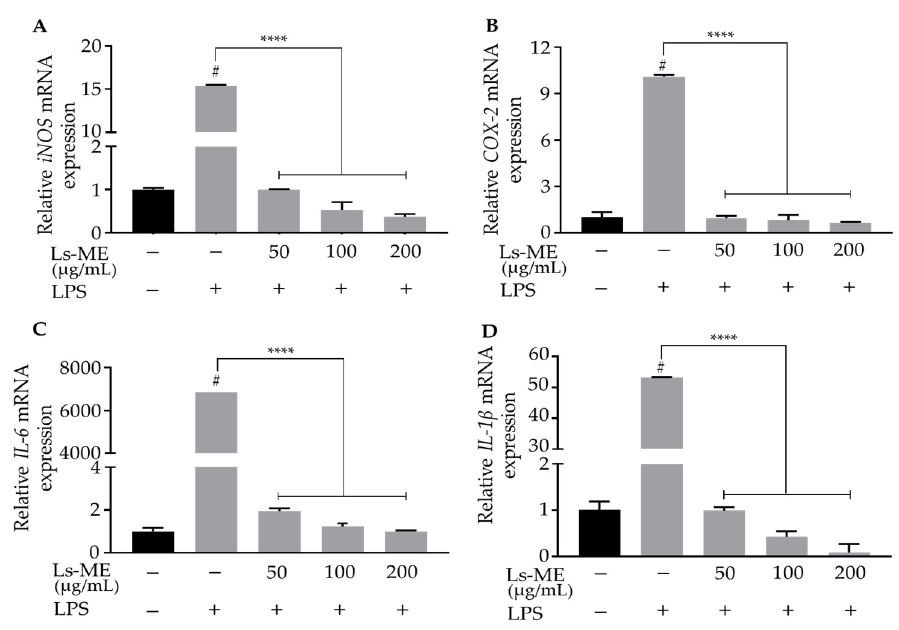
Figure 3. The inhibitory activity of Ls-ME on LPS-induced mRNA expression corresponding to pro-inflammatory genes in RAW 264.7 macrophages. Cells were cultured with serial concentrations of Ls-ME for 24 h, followed by treatment with LPS (1 µ g / mL) for 18 h. The mRNA levels of iNOS ( A ), COX-2 ( B ), IL-6 ( C ), and IL-1 β ( D ) genes were determined by RT-qPCR. Data of the three replicates are represented as mean ± SD. # p < 0.05 is expressed in comparison with cells incubated alone; **** p < 0.0001 is expressed in comparison with LPS treatment only; n. s., not significant.